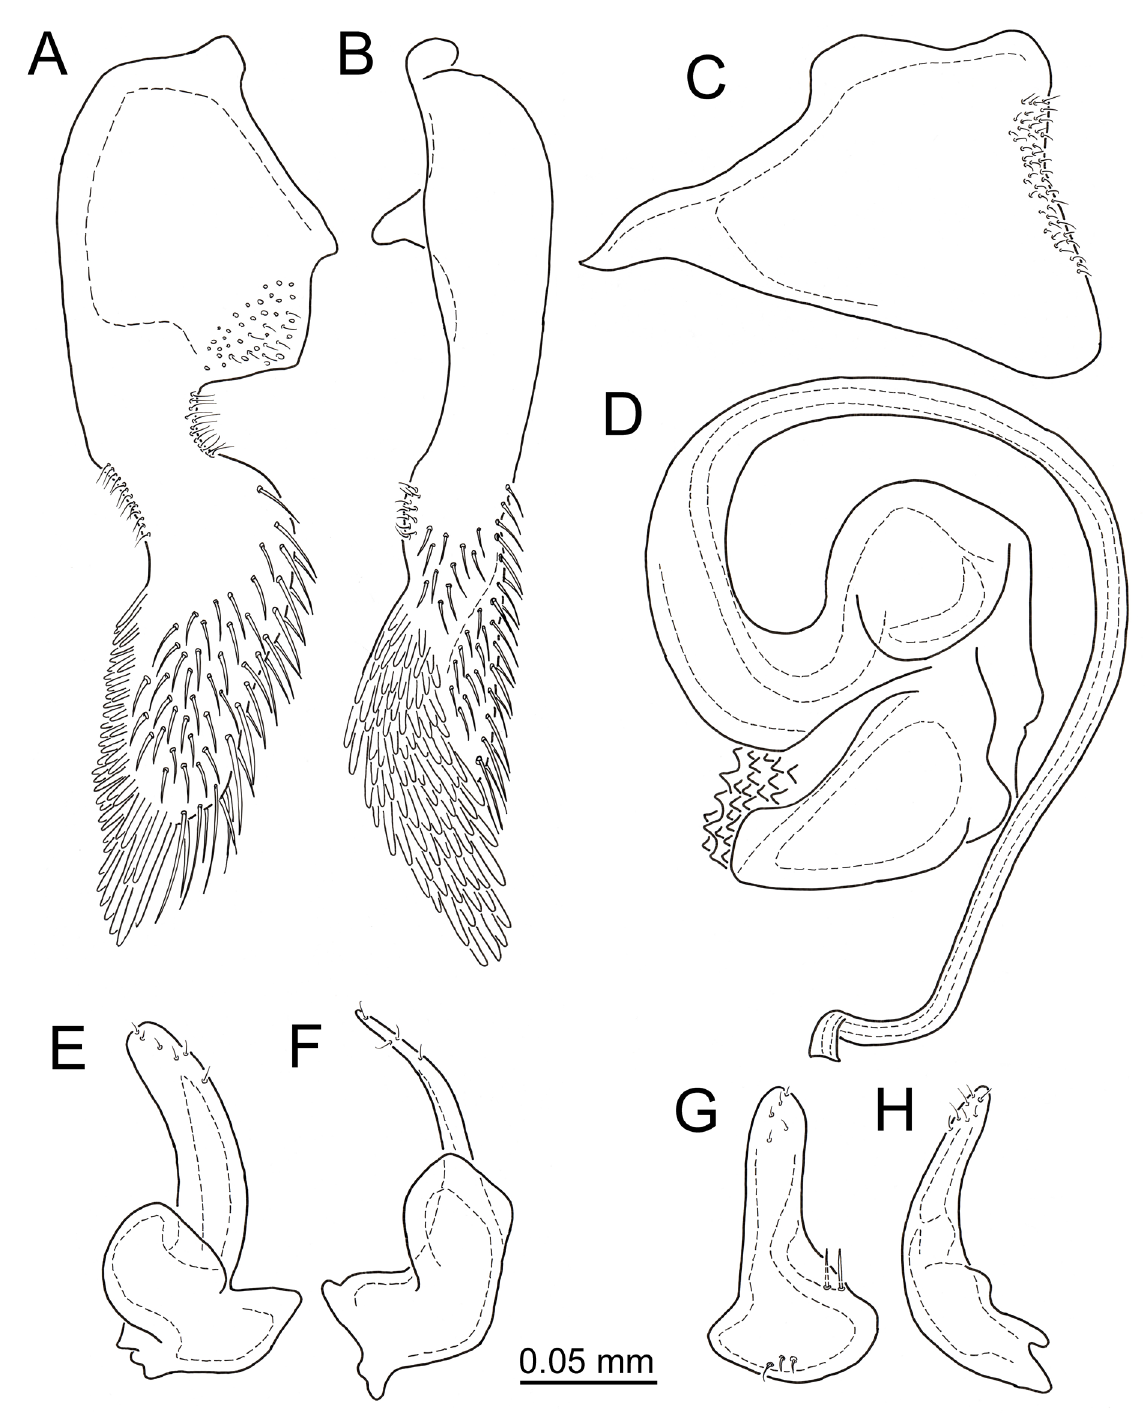
Fig. 24. Kokeshia xiei Rédei, Ren & Bu, 2012, segment VIII and genitalia, ♂ (SYSBM). A‒B . Left hemitergite VIII. A . Dorsal view. B . Left lateral view. C . Right hemitergite VIII, dorsal view. D . Phallus. E‒F . Left paramere, two different aspects. G‒H . Right paramere, two different